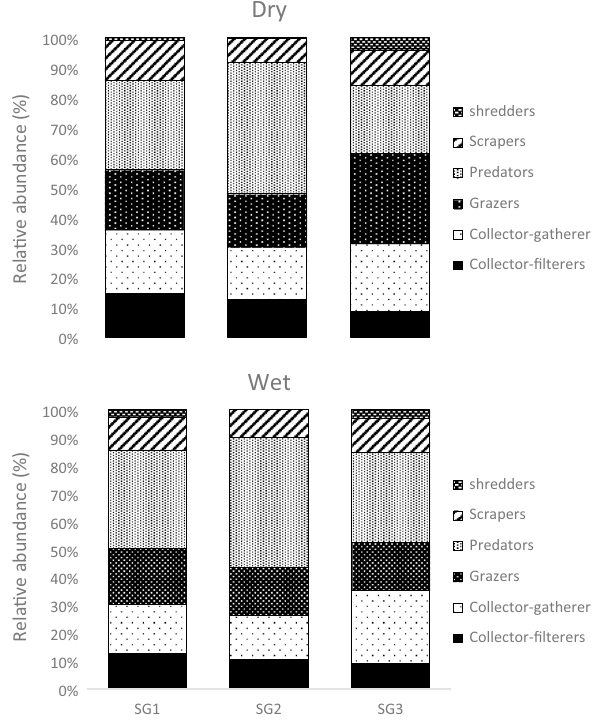
Figure 3. Relative abundance of macroinvertebrate functional feeding groups (FFGs) across the 11 river stations in three site categories Site group 1 (Site 1 = Adofi, Site 2 = Oleri, and Site 3 = Anwai upstream, Site 4 = Anwai downstream and Site 9 = Ogba upstream site), SG2: Site group 2 (Site 5 = Ethiope upstream, Site 6 = Ethiope downstream, Site 7 = Obosh and Site 8 = Ogba downstream) > SG3: Site group 3 (Site 10 = Orogodo and Site 11 = Warri River) during the dry and wet seasons.